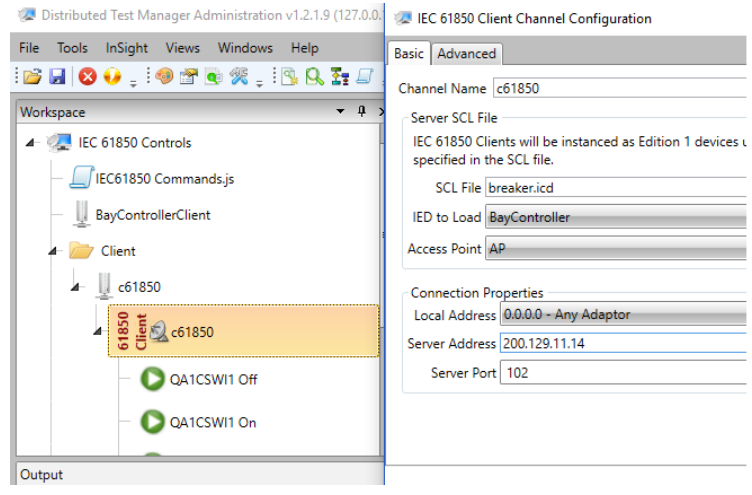
Figure 9. Screenshot of the IEC 61850 client configuration using DTM software.